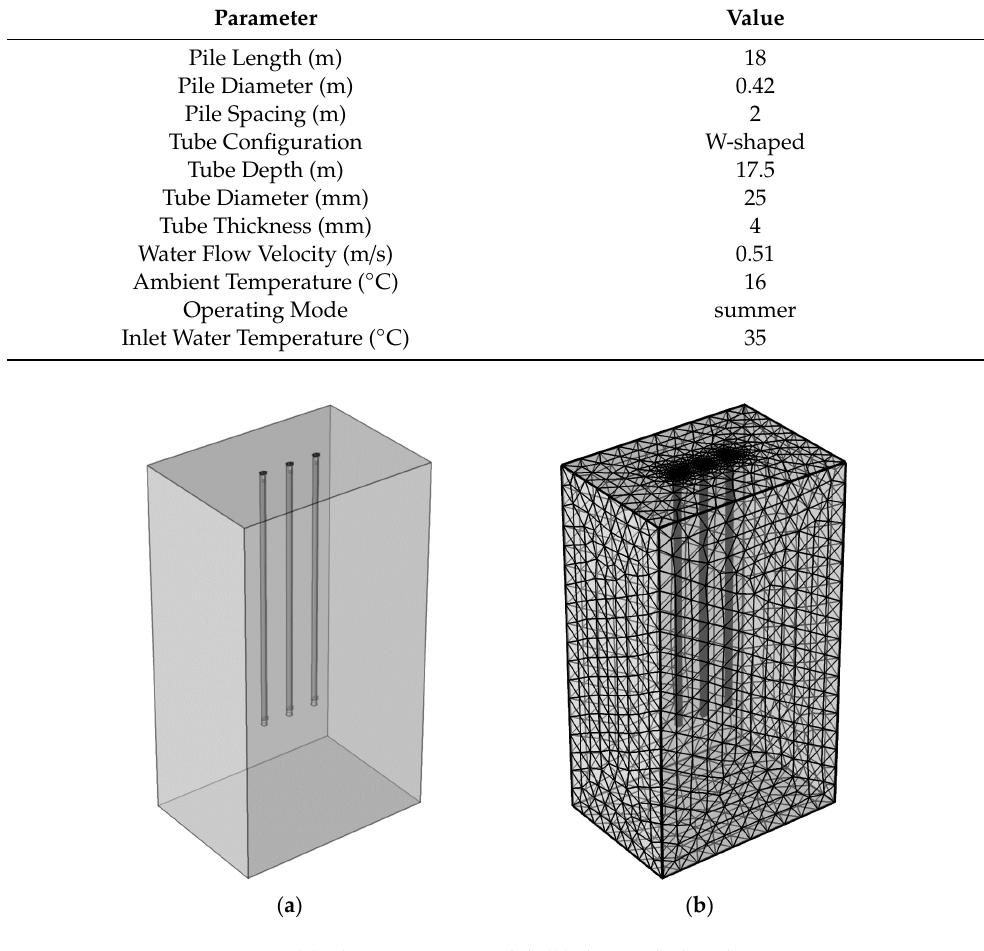
Figure 4. ( a ) The geometry model; ( b ) the mesh distribution. Table 5. Comparison of the outlet water temperature after 50 h of cooling between the present study and You et al.’s experiments [29]. Reprint with permission [4942921402906] from Energy and Buildings; published by Elsevier, Aug. 2014.